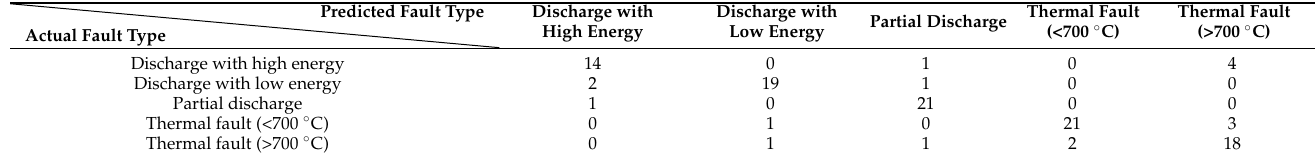
Table 5. Confusion matrix of the decision tree.